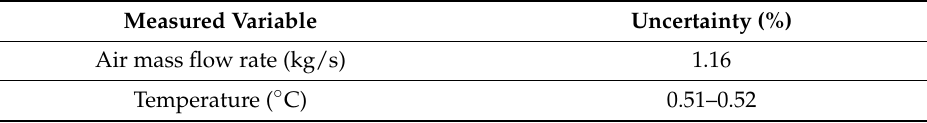
Table 3. Average uncertainty values.